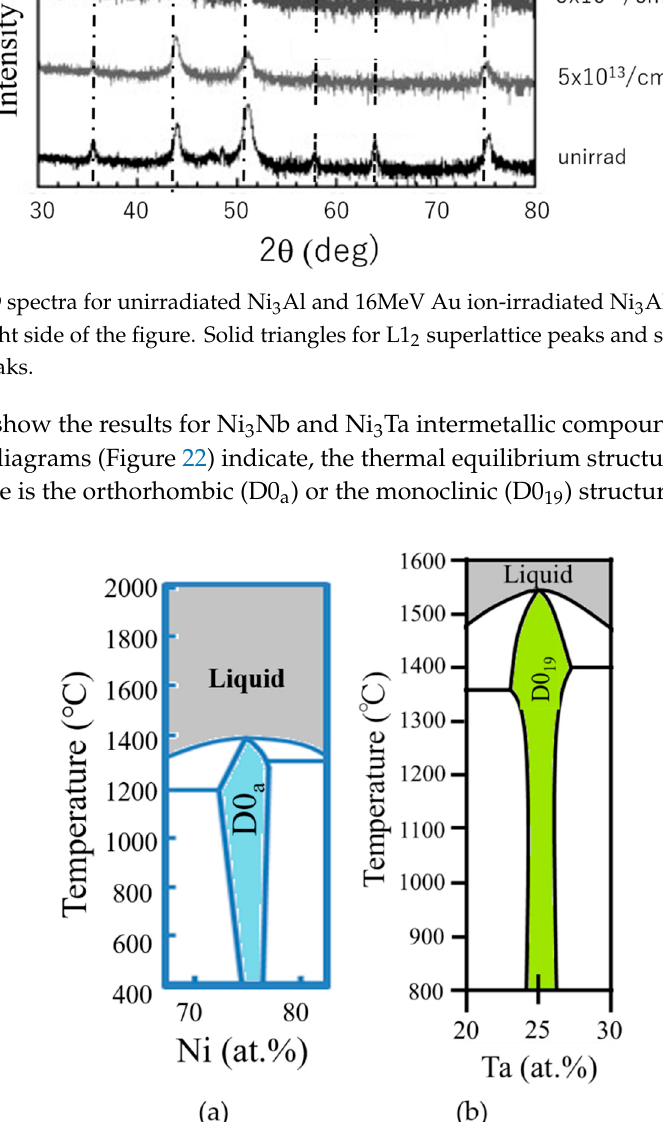
Figure 23. GIXD spectra for unirradiated and 16 MeV Au ion-irradiated Ni 3 Nb. Indices and solid diamonds in the figure correspond to orthorhombic structure. Ion fluences are shown at the right side of the figure.